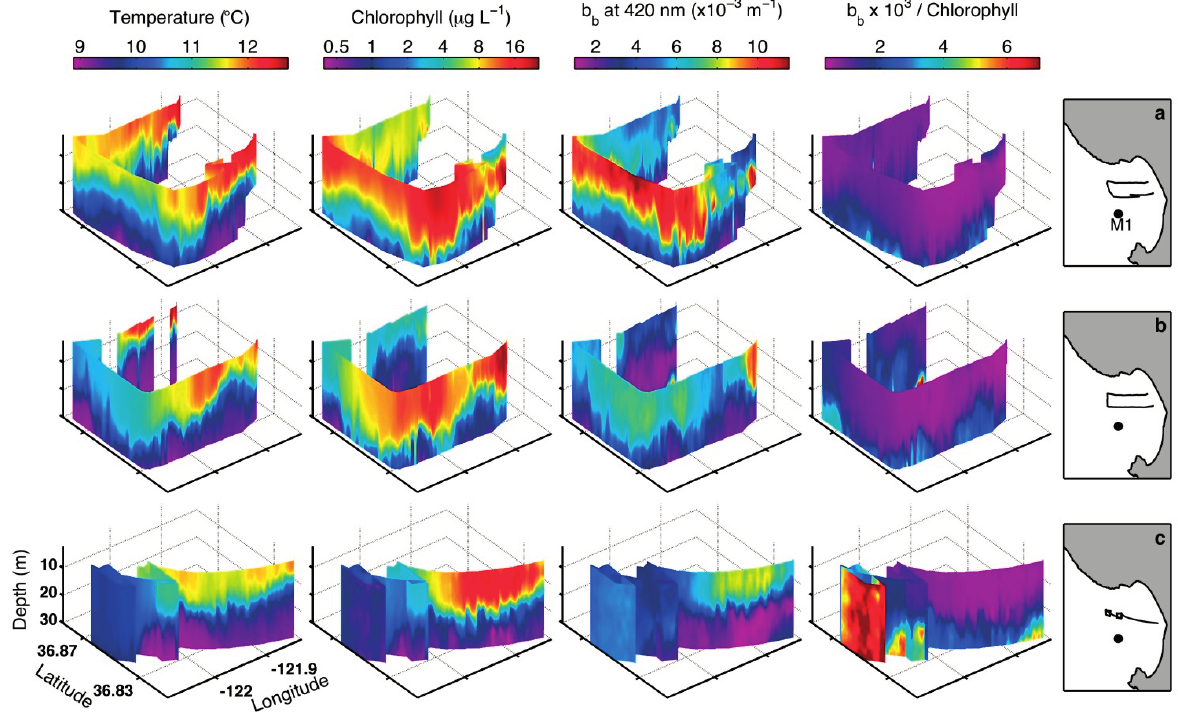
Figure 5. Spring 2011 study: Autonomous underwater vehicle (AUV) data shows upwelling influence in the water column; b b is optical backscattering. Rows a – c represent surveys in sequence (times shown in Figure 4a). The latitude/longitude/depth volume shown is the same in each data